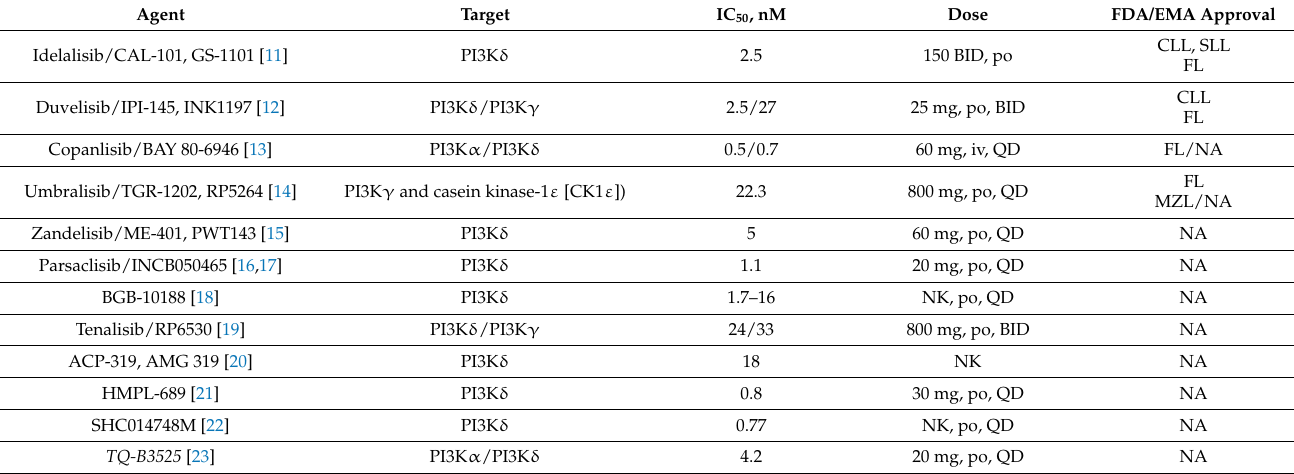
Table 1. Phosphoinositide 3-kinase inhibitors (PI3Ki) approved or potentially useful for chronic lymphocytic